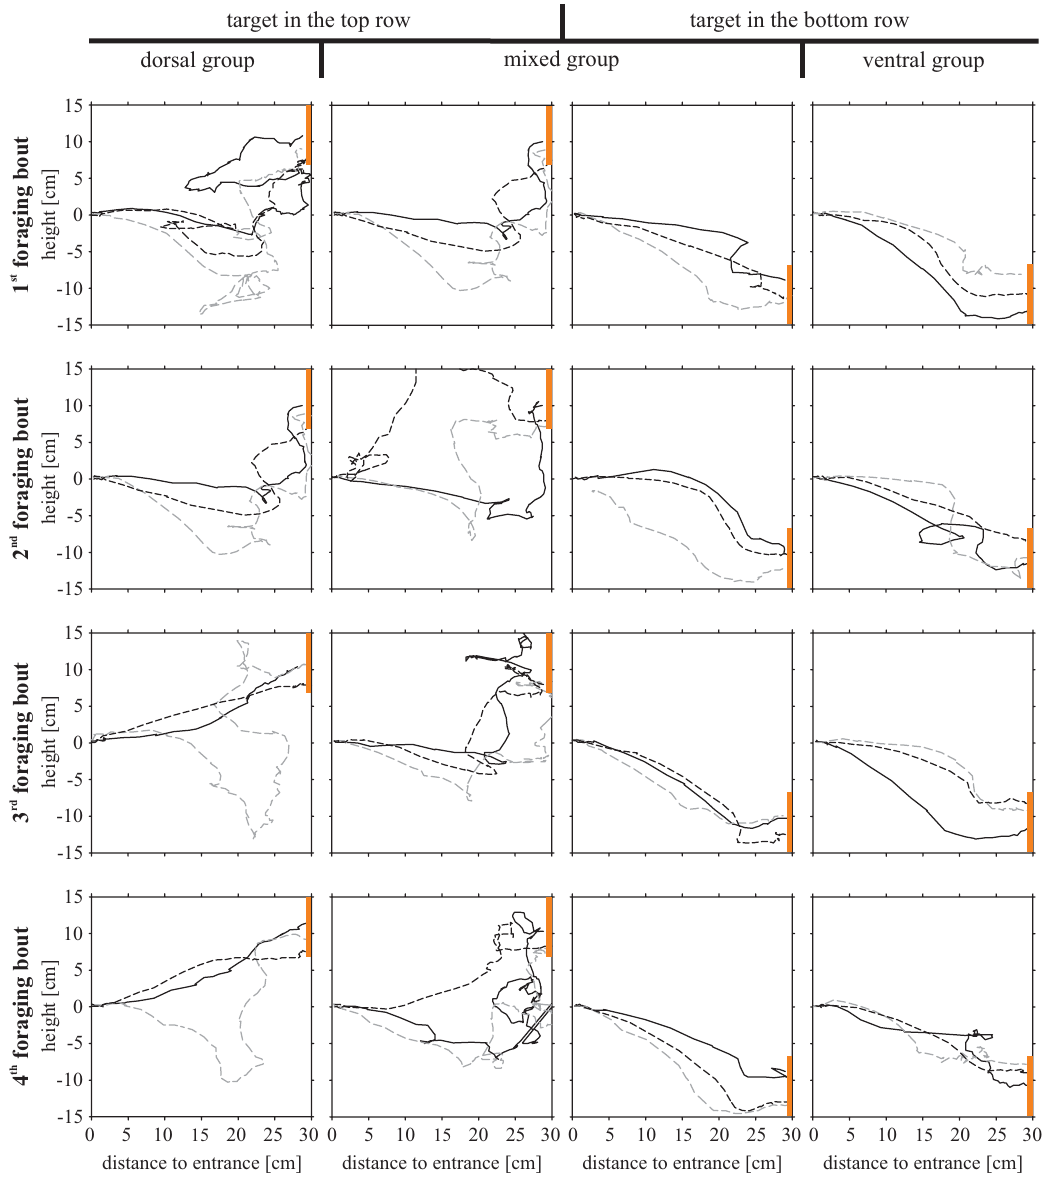
Figure 6. Flight paths of selected bees. The flight paths describe the differences in flight behaviour among the three experimental groups. The 16 squares represent cross sections of the flight box with the bee entering the box from the left side searching for the target (presented on the right side; orange bar). For each experimental group three individual bees are shown (straight black line, dashed black line, dashed grey